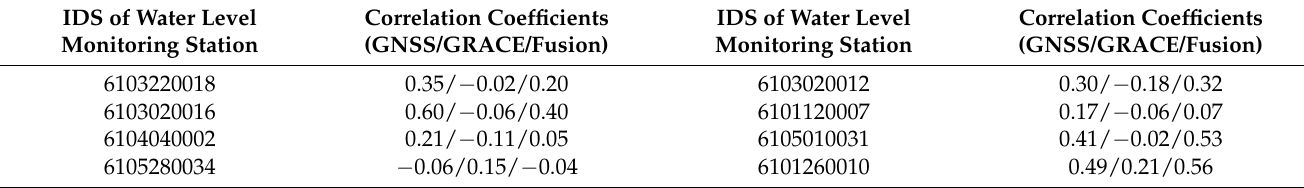
Table 2. Correlation coefficients between results from GNSS/GRACE, fusion method and in situ groundwater level